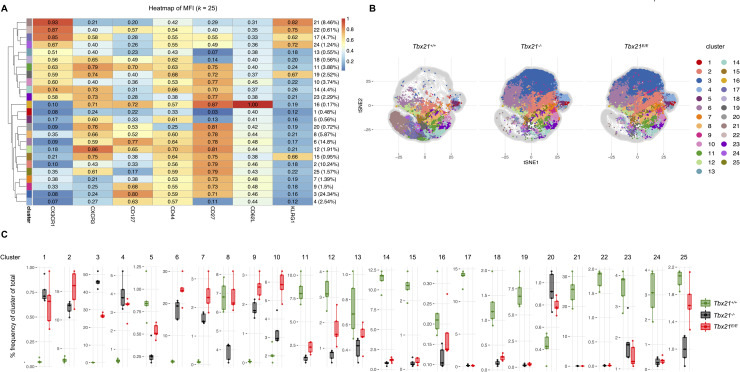
T-box TF jointly drive expansion of heterogeneous clusters of CTLs.(A) Heatmap of MFI of indicated surface markers (CX3CR1, CXCR3, CD127, CD44, CD27, CD62L, KLRG1) across the 25 cell populations obtained with FlowSOM after data was metaclustered with ConsensusClusterPlus. Dendrogram on the left represents hierarchical similarity between the 25 metaclusters. Color of heatmap represents the median of the arcsinh, 0–1 transformed marker expression calculated over cells from all samples (20,000 P14 cells per sample, n = 5 for each experimental group) with a color-coding chart on the right. Numbers denote expression values. Values in the brackets on the right indicate relative abundancy of clusters. (B) t-distributed stochastic neighbor embedding (t-SNE) map based on the arcsinh-transformed expression of surface markers (CX3CR1, CXCR3, CD127, CD44, CD27, CD62L, KLRG1) of P14 CD8 T cells. Plots represent 20,000 P14 cells, which are randomly assigned from each experimental group. Plots are stratified by indicated experimental group. Cells are color-coded according to the 25 cell populations that were obtained with FlowSOM after metaclustering the populations with ConsensusClusterPlus. (C) Frequency of indicated cluster of indicated experimental group is depicted. Box plots represent interquartile range (IQR). Horizontal line depicts median. Whiskers extend to the farthest data point within a maximum of 1.5 x IQR.